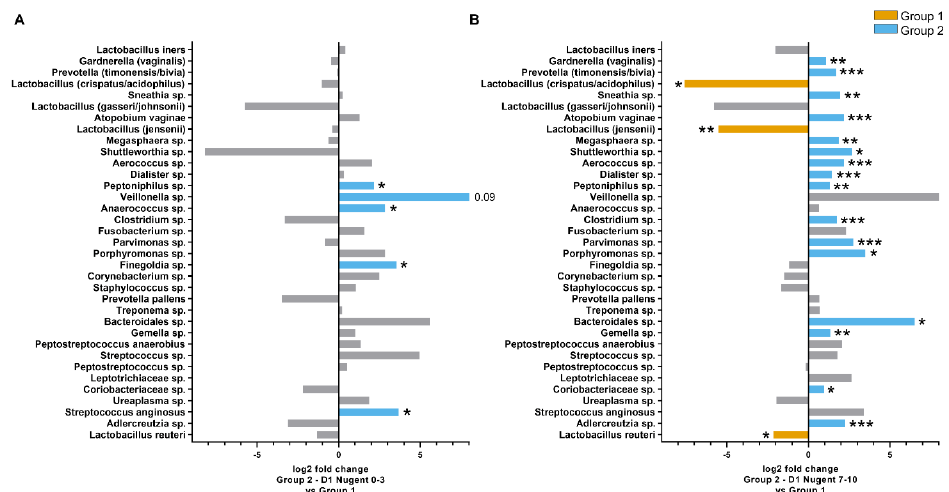
Figure 5. Di ff erences in the relative abundance of species in the vaginal microbiota between Group 1 and Group 2 Day 1 individuals with Nugent scores 0–3 ( A ) Group 2 Day 1 individuals with Nugent scores 7–10 ( B ). Taxa are listed in order of overall total abundance. *** FDR < 0.001, ** FDR < 0.01, * FDR <